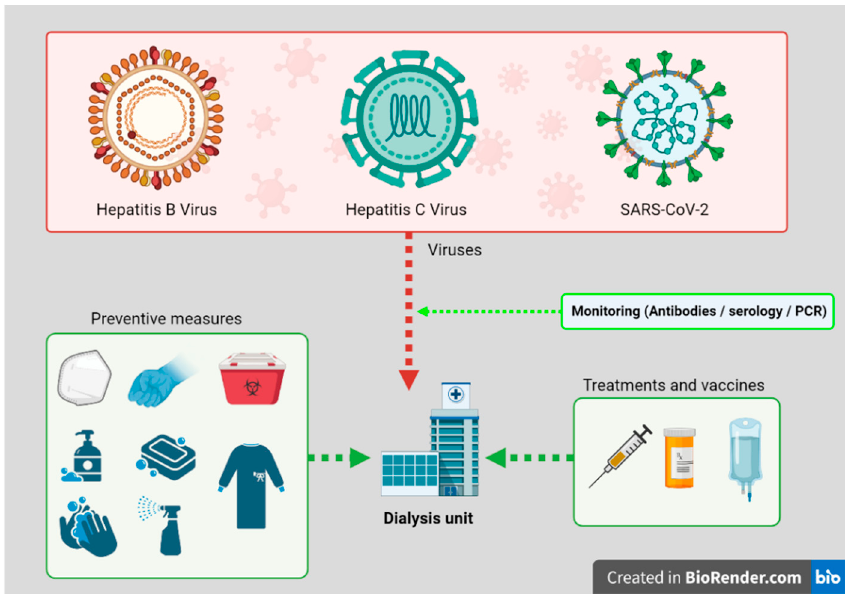
Figure 1. Preventive measures and treatment options against Hepatitis and SARS-CoV-2 viruses for dialysis units.